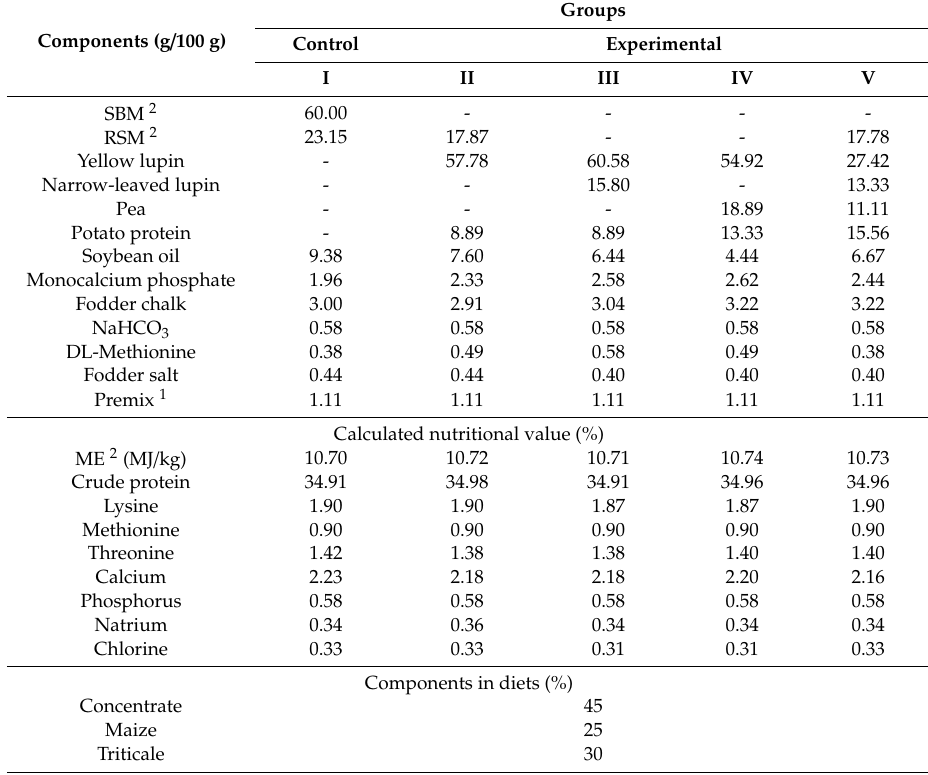
Table 2. Concentrates used in the first phase of duck